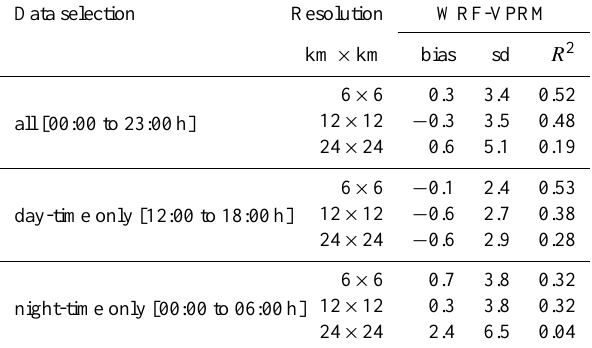
Table 3. Summary statistics of observed and simulated CO 2 fields for various model resolutions. The statistics includes model bias (bias), standard deviation of the differences (sd) and squared cor- relation coefficient ( R 2 ) which are calculated using 3-hourly time series data, separately for different data selections for the measure- ment level at 23m during August 2006. Simulated fields are gener- ated by WRF-VPRM. The bias and sd are in ppm